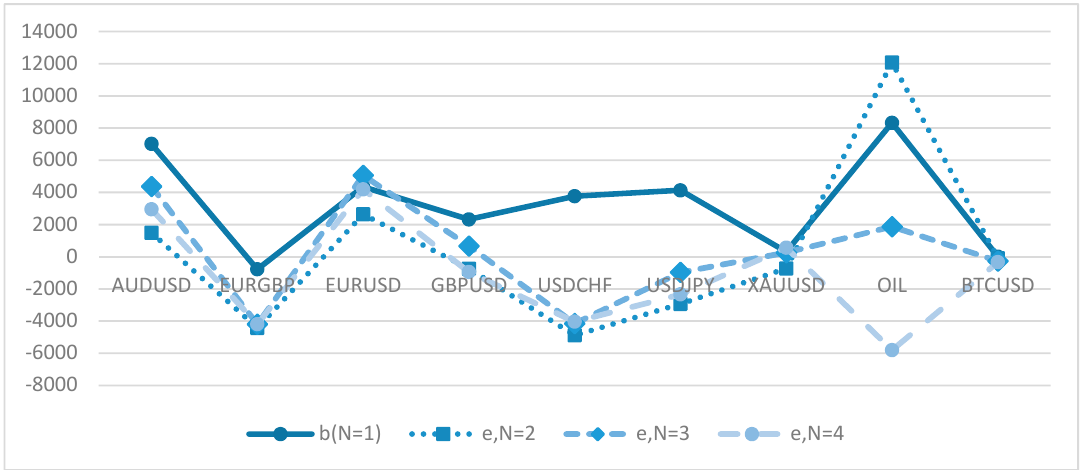
Figure 10. Net Profits of experiment (e) for various values of N.